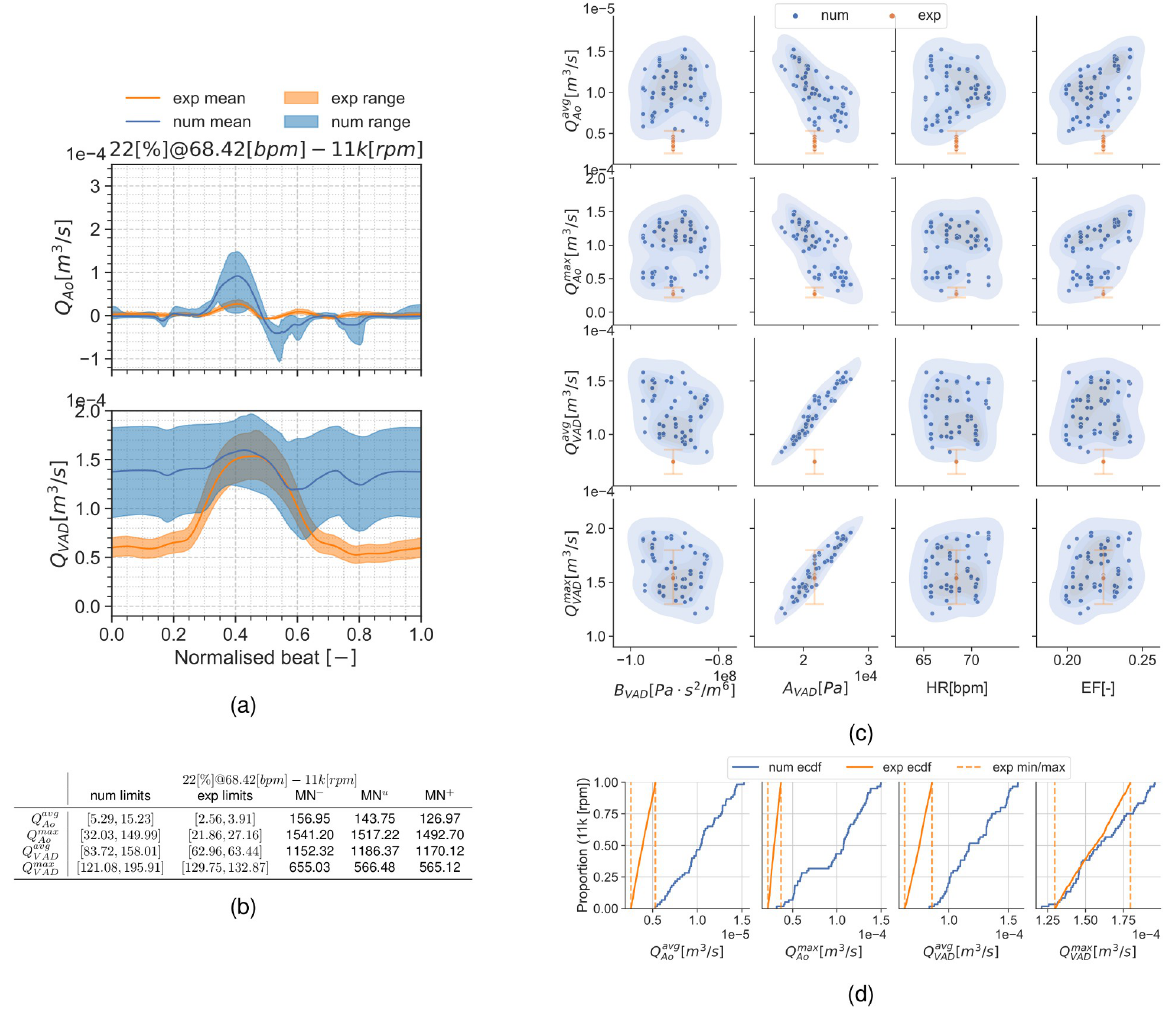
Fig 7. Summary for the condition 22[%]@68.42[ bpm ] and 11 k [ rpm ]. (a): aortic valve and LVAD flows. (b): validation metrics. (c): scatter plot showing the simulation and experimental data. (d): ECDF for the simulation, experimental data limits and the constructed uniform distribution.